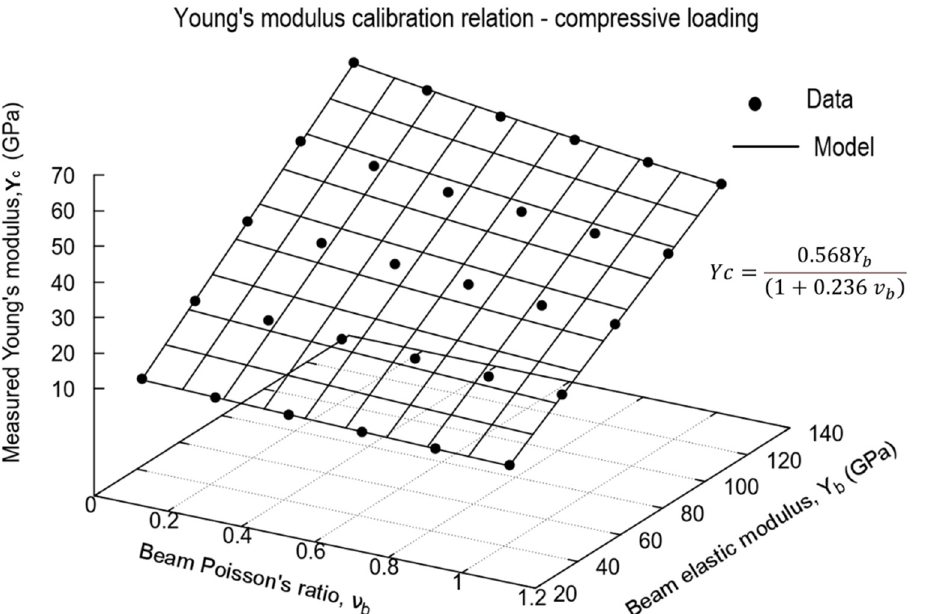
Figure A6. Plot of σ c /C b against tan θ fitted with Equation (A2).